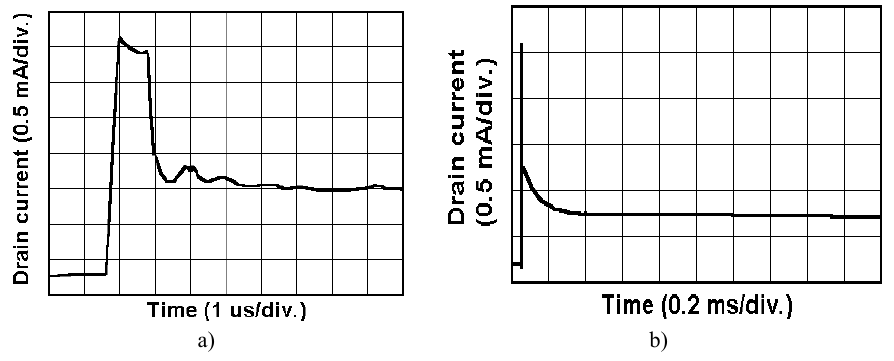
Fig. 4. pHEMT drain current response to pulse laser radiation (660 ns, 7.6 · 10 8